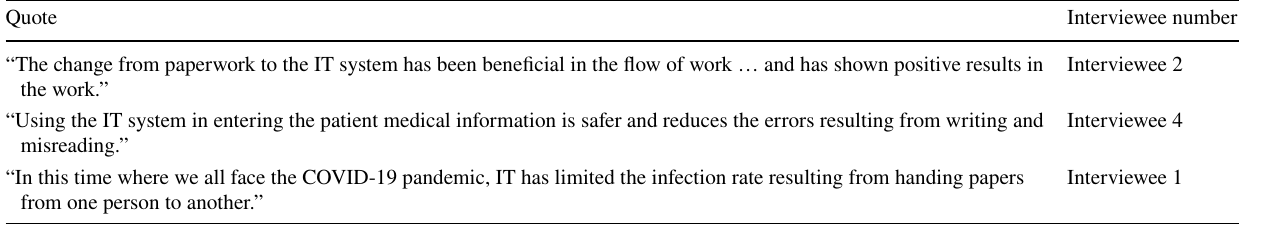
Table 1 Positive effects of IT on healthcare through improving the level of service